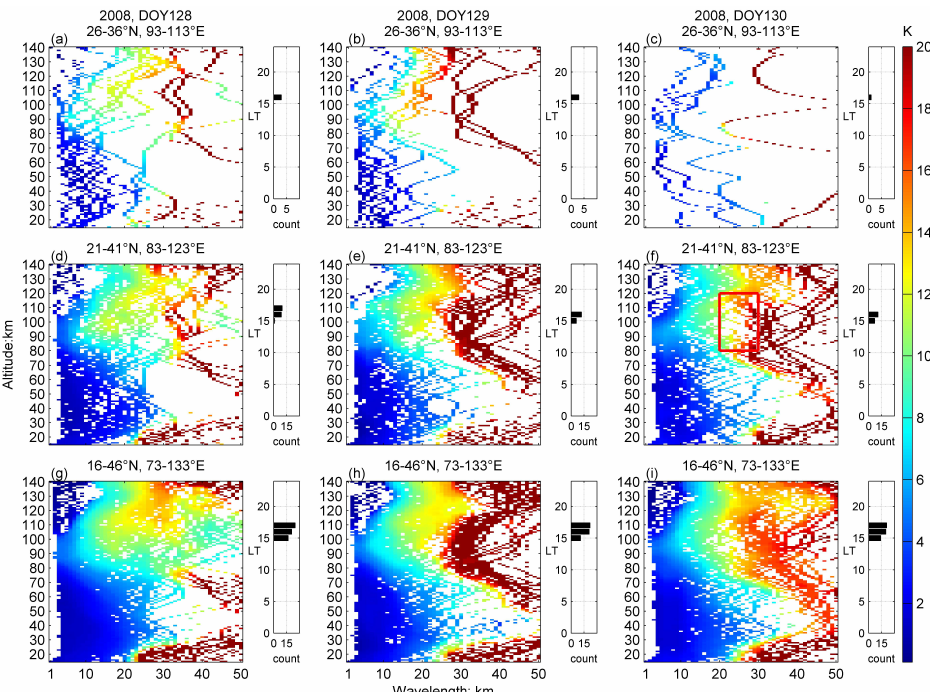
Fig. 8. The change of the Hilbert spectra in three square areas shown in Fig. 6 for three days (DOY 128, 129, and 130) for the Wenchuan earthquake. The horizontal bar graphs beside the spectra denote the number and local time of the measurements. The red square in (f) encloses the region within 20–30km wavelength and 80–120km altitude.